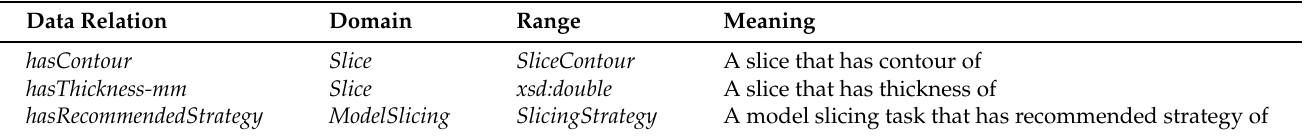
Table 6. Domain, range, and meaning of three relations in model